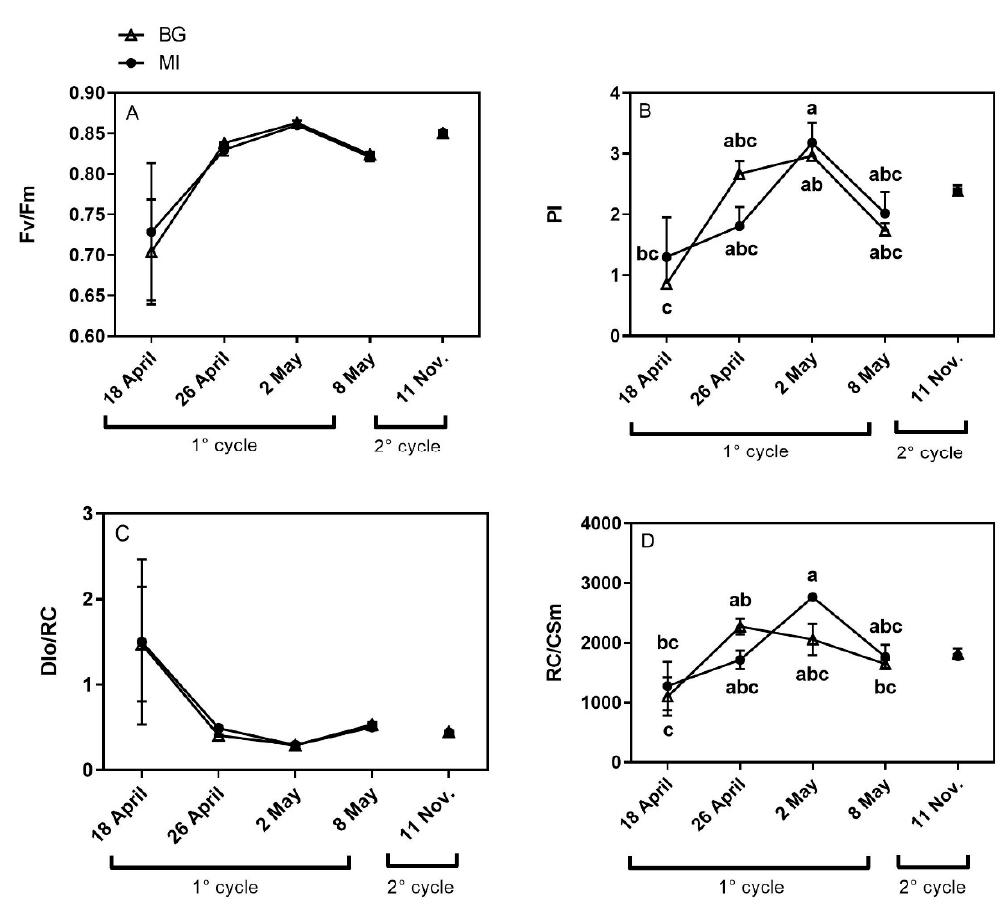
Figure 1. Chlorophyll a fluorescence parameters (Fv/Fm ( A ), PI ( B ), DIo/RC ( C ), and RC/CSm ( D )) in leaves of two hedge mustard wild populations, MI and BG. Data are means with standard errors ( n = 4 for April and May, n = 5 for November). Data of cycle I were subjected to two-way ANOVA and differences among wild populations and dates within cycles were determined using Tukey’s test ( P < 0.05). Data of cycle II were analysed using a t -test ( P < 0.05). Different letters indicate statistical differences, and no letters indicate no significant differences.